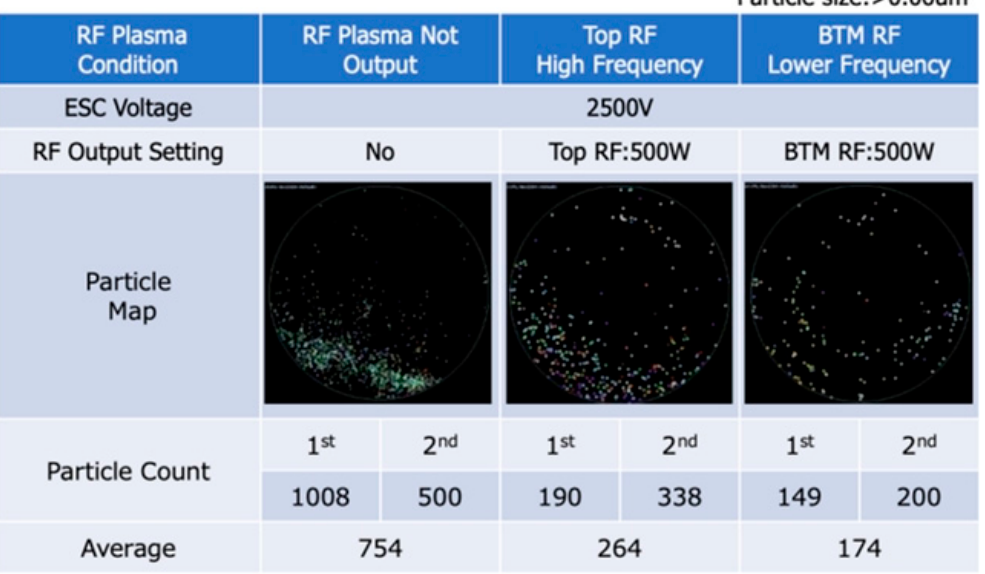
Figure 12. Particle distributions under the following RF settings: no plasma output, top RF (high frequency) output, and BTM RF (low frequency)